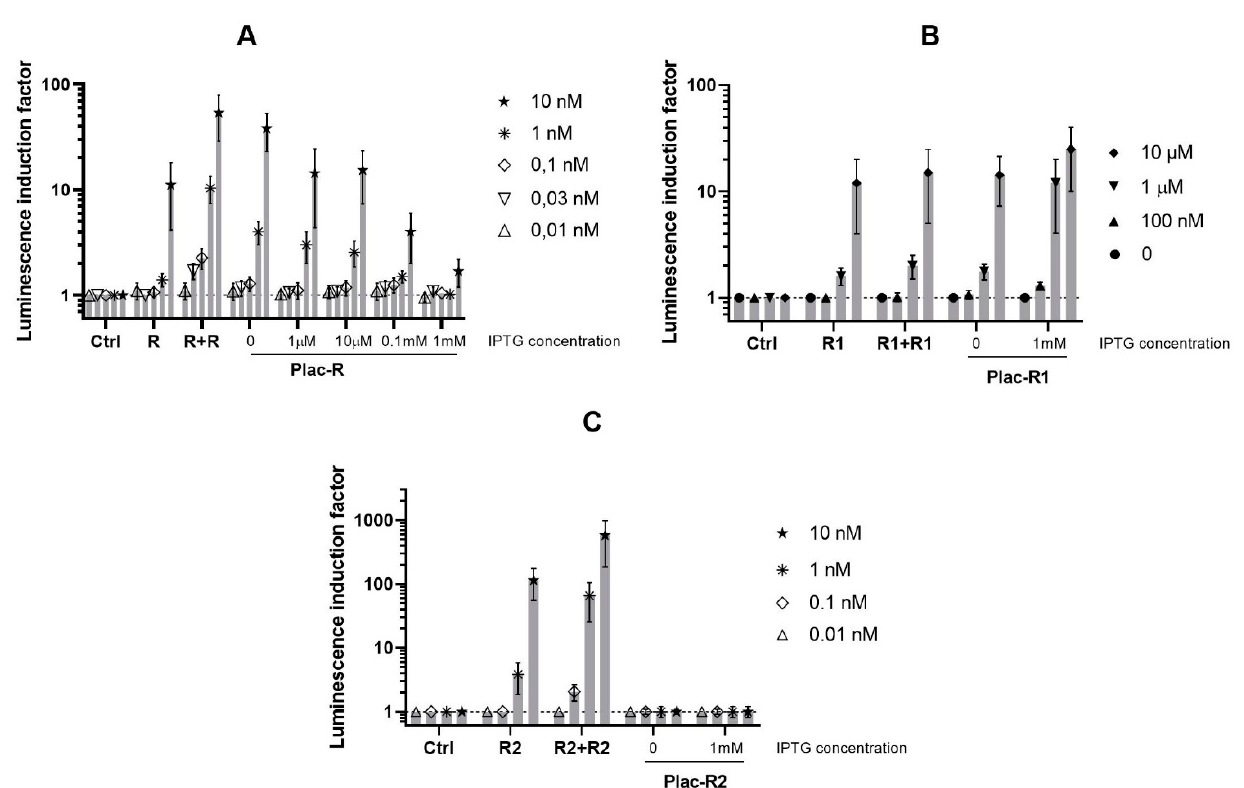
Figure 2. AI-dependent induction of luminescence of biosensor cells E. coli MG1655 with luxCDABE P. luminescence under control of LuxR-inducible promoter and luxR A. fischeri , luxR1 , or luxR2 A. logei. Curves show the dependence of induction by specific AI concentration on regulatory gene dosage and its expression level (regulated with IPTG). The following plasmids were used: ( A ) pR2 (Ctrl, negative control without any luxR gene), pVFR1 (R, single luxR A. fischeri copy on pDEW201 vector), pVFR1 and pSVRAF (R + R, additional copy of luxR A. fischeri on pACYC184 vector), or pOM and pGEX-LuxR (Plac-R, luxR A. fischeri under P lac ); ( B ) pR2 (Ctrl), pIVA (R1, single luxR1 A. logei copy on pDEW201), pIVA and pIV3 (R1 + R1, additional copy of luxR1 A. logei on pACYC184), pR2 and p15Tc-luxR1 (Plac-R1, luxR1 A. logei under P lac ); ( C ) pR2 (Ctrl), pSV16 (R2, single luxR2 A. logei copy on pDEW201), pSV16 and pIV2 (R2 + R2, additional copy of luxR2 A. logei on pACYC184), or pR2 and p15Tc-luxR2 (Plac-R2, luxR2 A. logei under P lac ). The graphs show the average of three independent replicates.